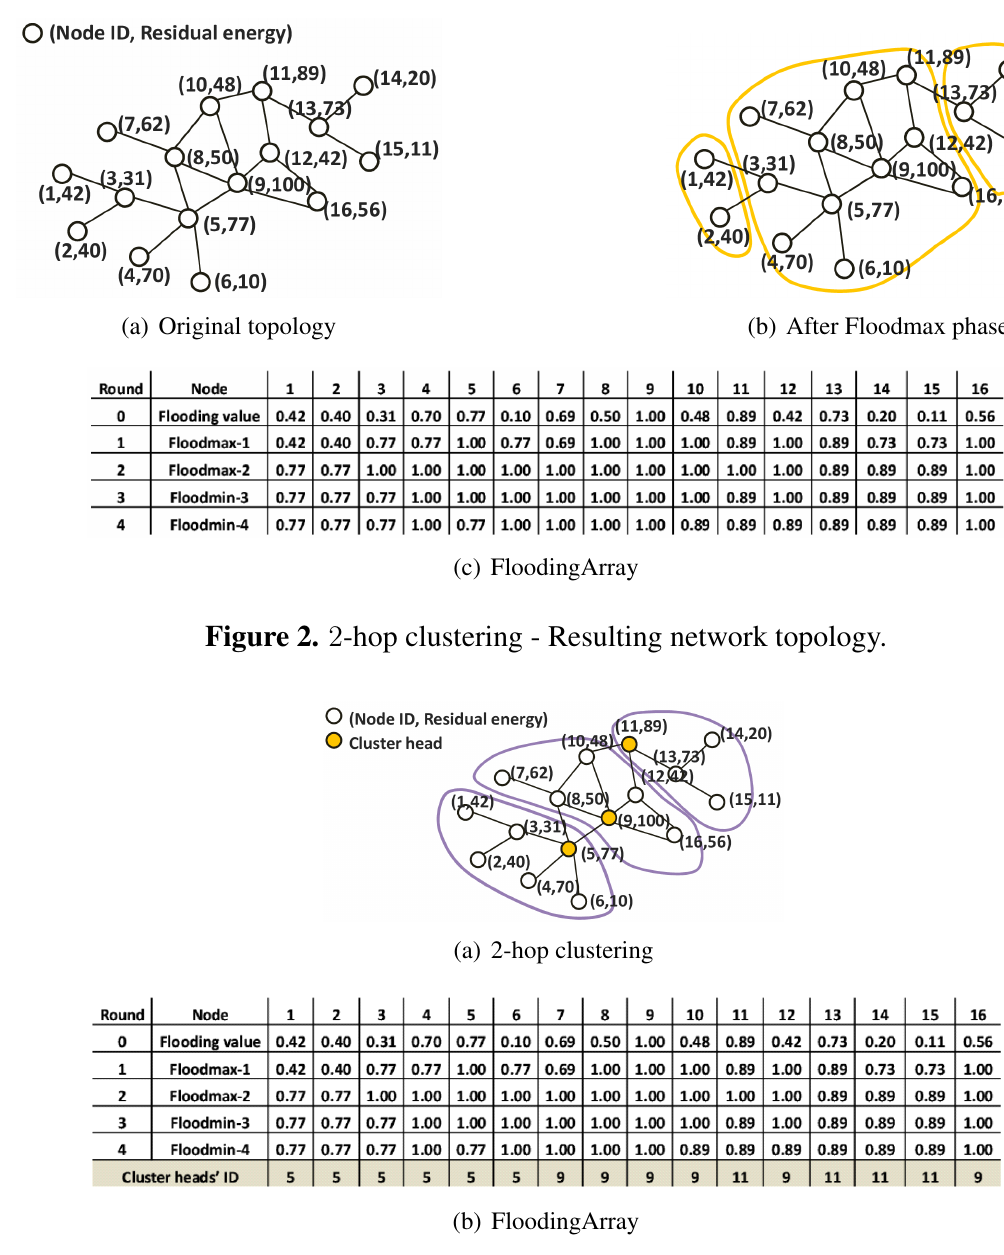
Figure 1. 2 -hop clustering - Floodmax and Floodmin phase.